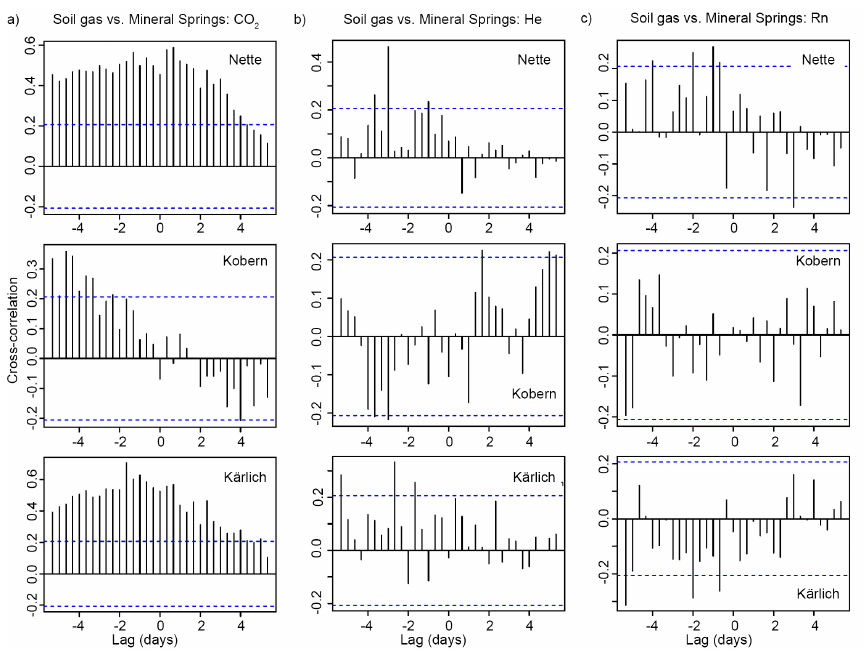
Figure A6. Cross-correlation of the time-series of SG mean vs. mineral springs (8-hour median smoothed) for ( a ) CO 2, ( b ) He, and ( c ) Rn for the 4-W samples. Blue dashed lines indicate confidence thresholds.